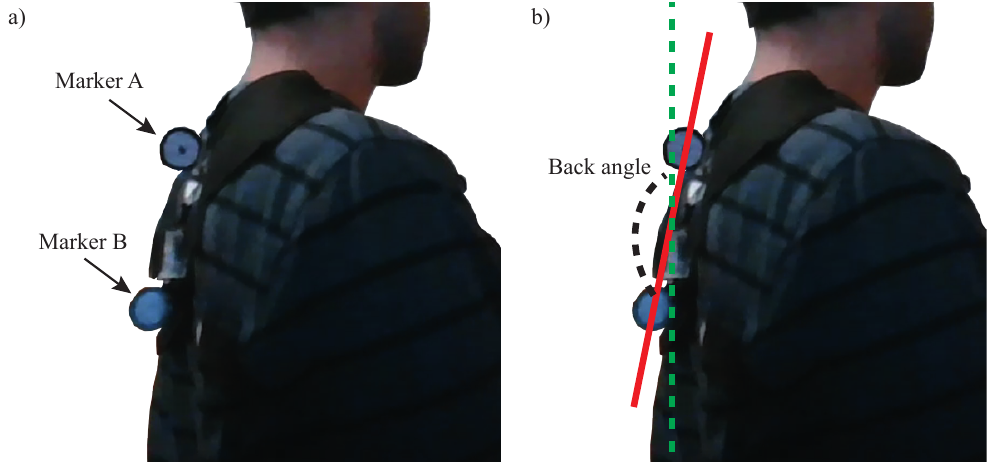
Figure 6. ( a ) Photograph of the user wearing the device. The two round markers were used to allow the Kinovea software to track the movement of the back during the exercise. ( b ) Used back angle. The angle of the back is taken as the angle between the line that crosses both markers and a vertical line (parallel to the gravitational acceleration